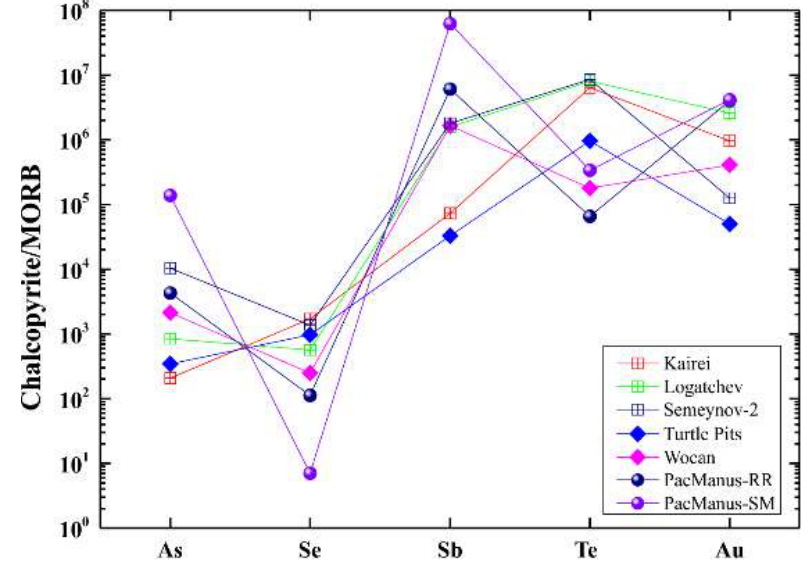
Figure 10. Selected MORB-normalized trace element patterns for chalcopyrite from different seafloor hydrothermal systems. MORB data source from Arevalo and McDonough (2010) [48]. Supplementary Materials: The following are available online at http://www.mdpi.com/2075-163X/8/11/526/s1, Table S1: LA-ICP-MS reference materials, Table S2: Trace and main element concentrations (ppm) of the analyzed sulfides at the Kairei vent field obtained from LA-ICP-MS and EPMA.